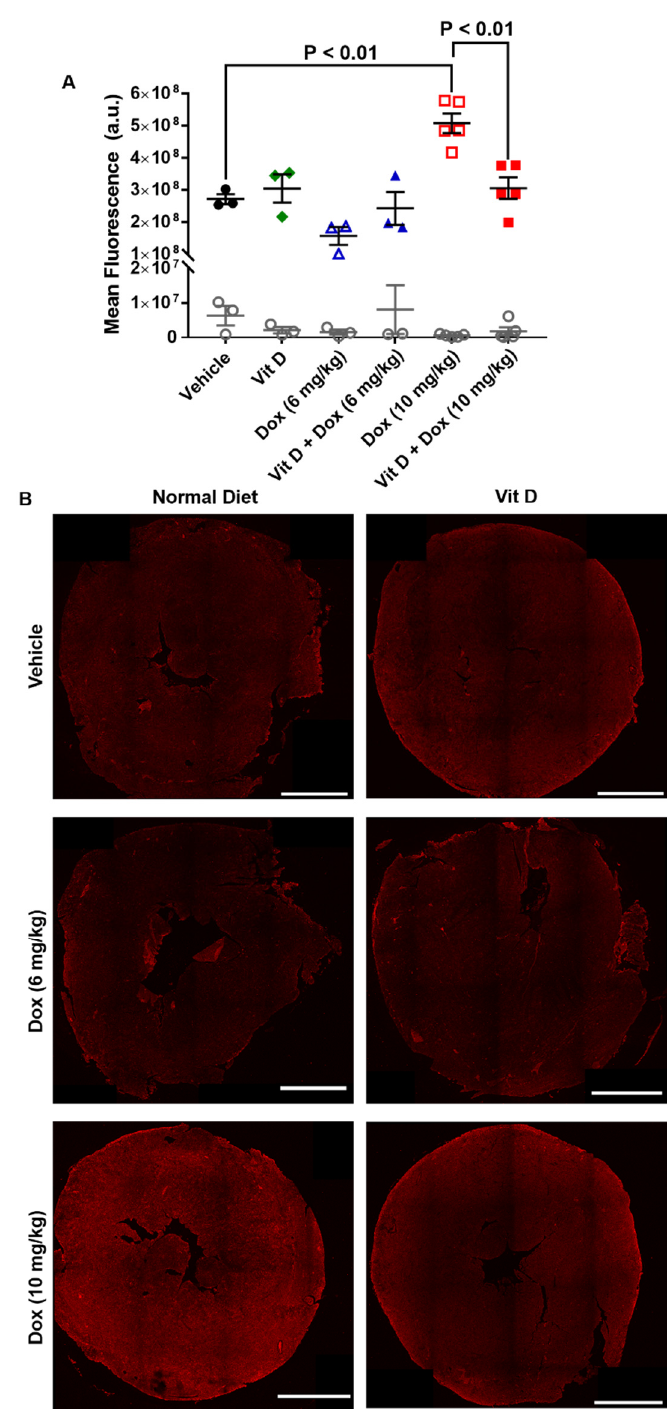
Figure 3. Levels of 4-hydroxynonenal in cardiac tissue of mice treated with vitamin D and doxoru- bicin. ( A ) Fluorescence intensity of cardiac 4-HNE. Comparison of Dox (10 mg/kg), (5.1 ± 0.3) × 10 8 AU vs. vehicle, (2.7 ± 0.2) × 10 8 AU; p < 0.01. Comparison of Dox (10 mg/kg), (5.1 ± 0.3) × 10 8 AU vs. Vit D + Dox (10 mg/kg), (3.1 ± 0.3) × 10 8 AU; p < 0.01. Comparison of Vit D, (3.0 ± 0.04) × 10 8 AU; Dox (6 mg/kg), (1.6 ± 0.3) × 10 8 AU; or Vit D + Dox (6 mg/kg), (2.4 ± 0.5) × 10 8 AU vs. vehicle were non- significant. ( B ) Representative sections of cardiac tissue (thickness, 5 µm) showed the greatest 4- HNE (shown in red) fluorescence intensity for mice treated with Dox (10 mg/kg). Dox (10 mg/kg) and Vit D + Dox (10 mg/kg), five mice per group; all other groups, three mice per group (scale bar, 1000 µm).